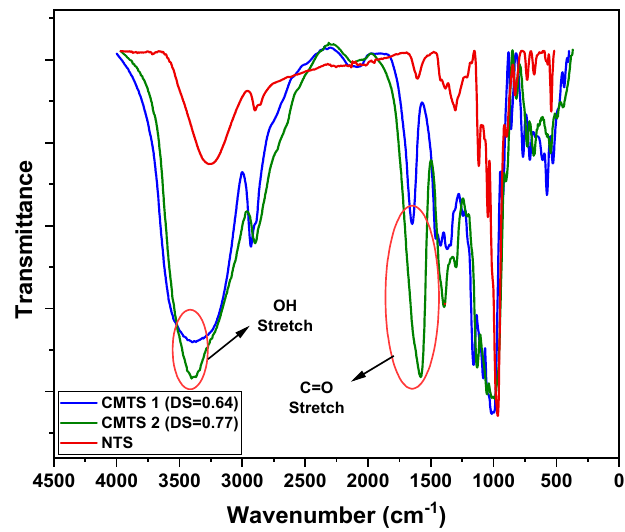
Figure 2. FTIR Spectra of NTS, CMTS 1, and CMTS 2.